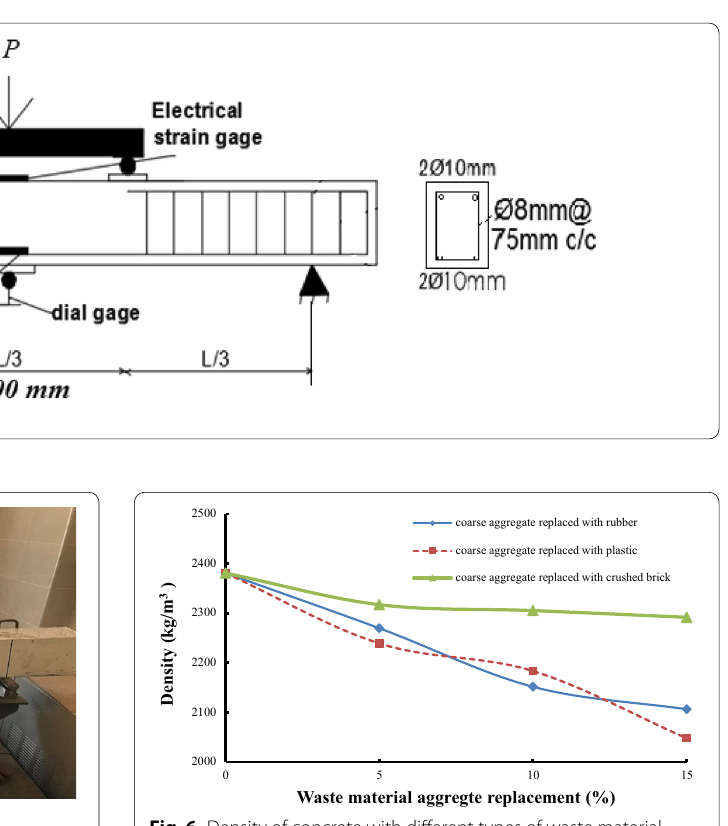
Fig. 6 Density of concrete with different types of waste